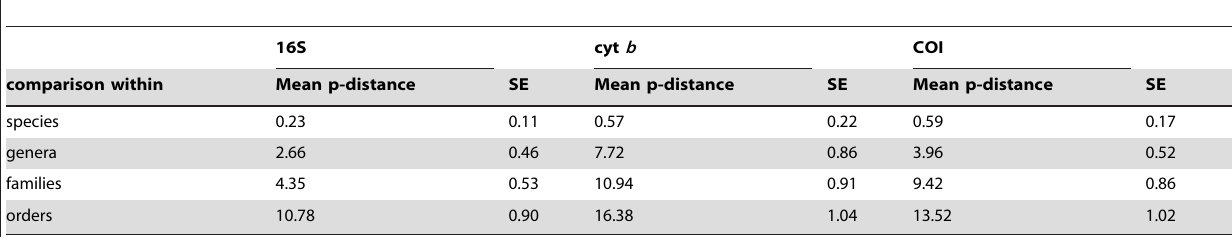
Table 2. Summary of genetic p-distances (%) within different taxonomic